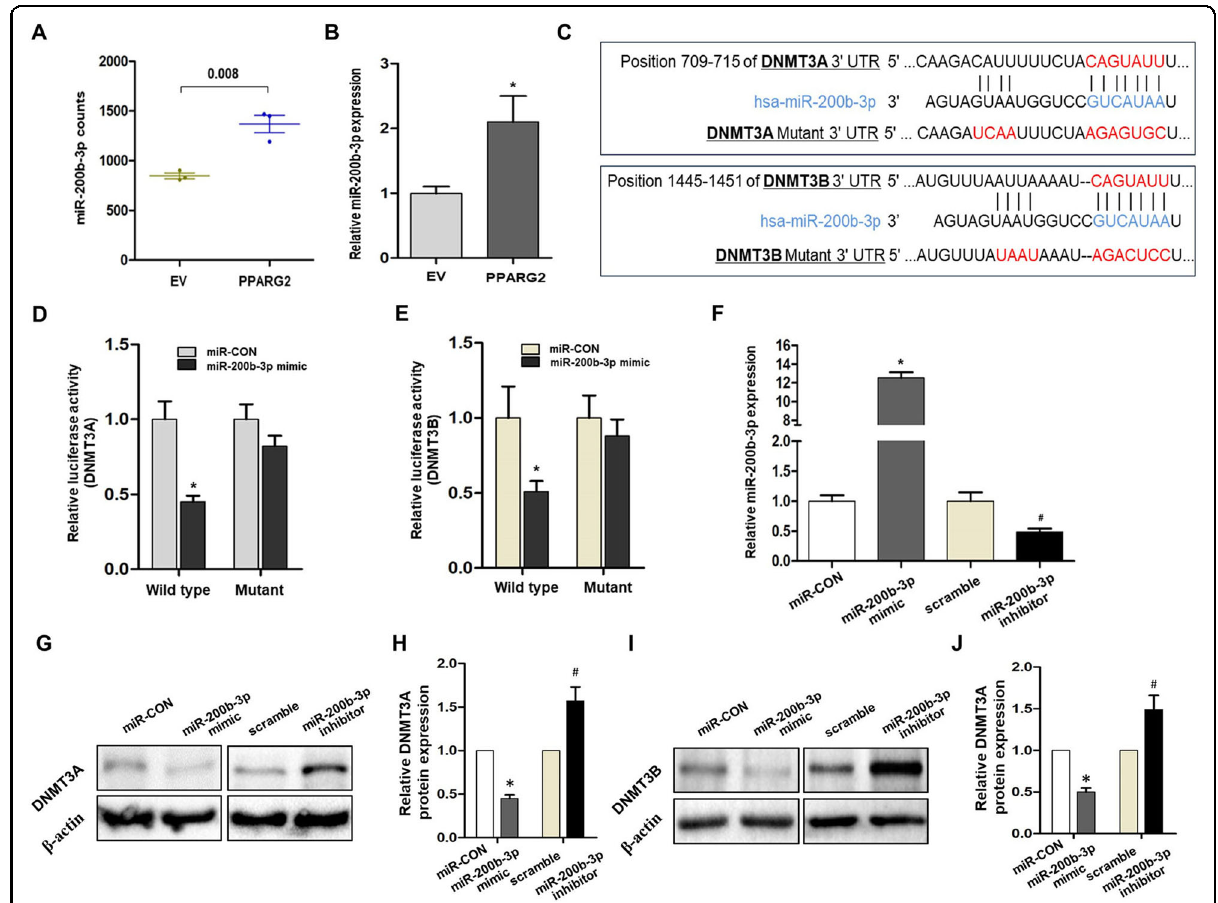
Fig. 7 Experimental veri fi cation of the relationship between DNMT3A/3B and miR-200b-3p. A miR-200b-3p expression extracted from miRNA- seq results ( n = 3, P = 0.008). B Relative miR-200b-3p expression in vitro when overexpression of PPARG2 . * P < 0.05 vs. EV group. C Putative miR-200b- 3p-binding 3 ′ -UTR sequence of DNMT3A/3B mRNA. Mutation was generated on the DNMT3A/3B mRNA 3 ′ -UTR sequence in the complementary site for the seed region of miR-200b-3p. The wild-type or mutant miR-200b-3p-binding DNMT3A/3B mRNA 3 ′ -UTR sequence was cloned into pmiR luciferase reporter. D The wild-type (DNMT3A/3 ′ -UTR-WT) and mutant (DNMT3A/3 ′ -UTR-Mut) pmiR luciferase reporter were co-transfected into PC3 cells with miR-CON and miR-200b-3p. * P < 0.05 vs. miR-CON group. E The wild-type (DNMT3B/3 ′ -UTR-WT) and mutant (DNMT3B/3 ′ -UTR-Mut) pmiR luciferase reporter were co-transfected into PC3 cells with miR-CON and miR-200b-3p. * P < 0.05 vs. miR-CON group. F Relative miR-200b-3p expression in vitro transfected with miR-200b-3p mimic or miR-200b-3p inhibitor by RT-qPCR. U6 was used as an internal control. * P < 0.05 vs. miR- CON group, # P < 0.05 vs. scramble group. G , H Analysis of DNMT3A protein expression by western blotting when transfected with miR-CON, miR- 200b-3p mimic, scramble, or miR-200b-3p inhibitor into PC3 cells. β -Actin was used as an internal control. * P < 0.05 vs. miR-CON group, # P < 0.05 vs. scramble group. I , J Analysis of DNMT3B protein expression by western blotting when transfected with miR-CON, miR-200b-3p mimic, scramble, or miR-200b-3p inhibitor into PC3 cells. β -Actin was used as an internal control. * P < 0.05 vs. miR-CON group, # P < 0.05 vs. scramble